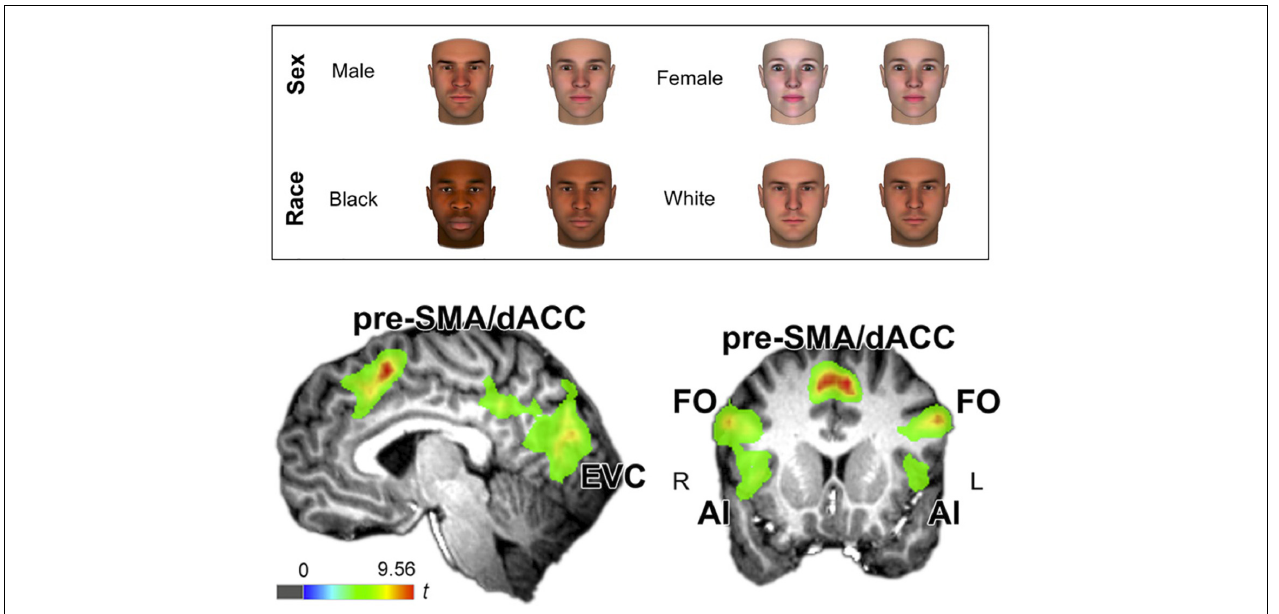
FIGURE 1 | From Stolier and Freeman (2017) (CC-BY). Above: This example shows the use of stimuli in Cognitive Neuroscience. It demonstrates the challenge when attempting to visualize categories of social identity and it also demonstrates how these attempts reify structural power because, as shown, here, the category of “Black woman” misses it again to be shown. Below: The brain images show the neurobiological correlates of “atypicality”. Participants were presented with faces that had to be categorized corresponding to their “gender and racial typicality”. Activation was found in the cingulo-opercular network consisting of presupplementary motor area and dorsal anterior cingulate cortex (pre-SMA/dACC) and, centrally, the anterior insula/ and the frontal operculum (AI/FO). This pattern of activation suggests the engagement of conflict monitoring when atypical faces are shown. R: right, L: left. EVC: early visual cortex, specific brain activation discussed elsewhere in the cited paper showing the processing of target categories presented in the